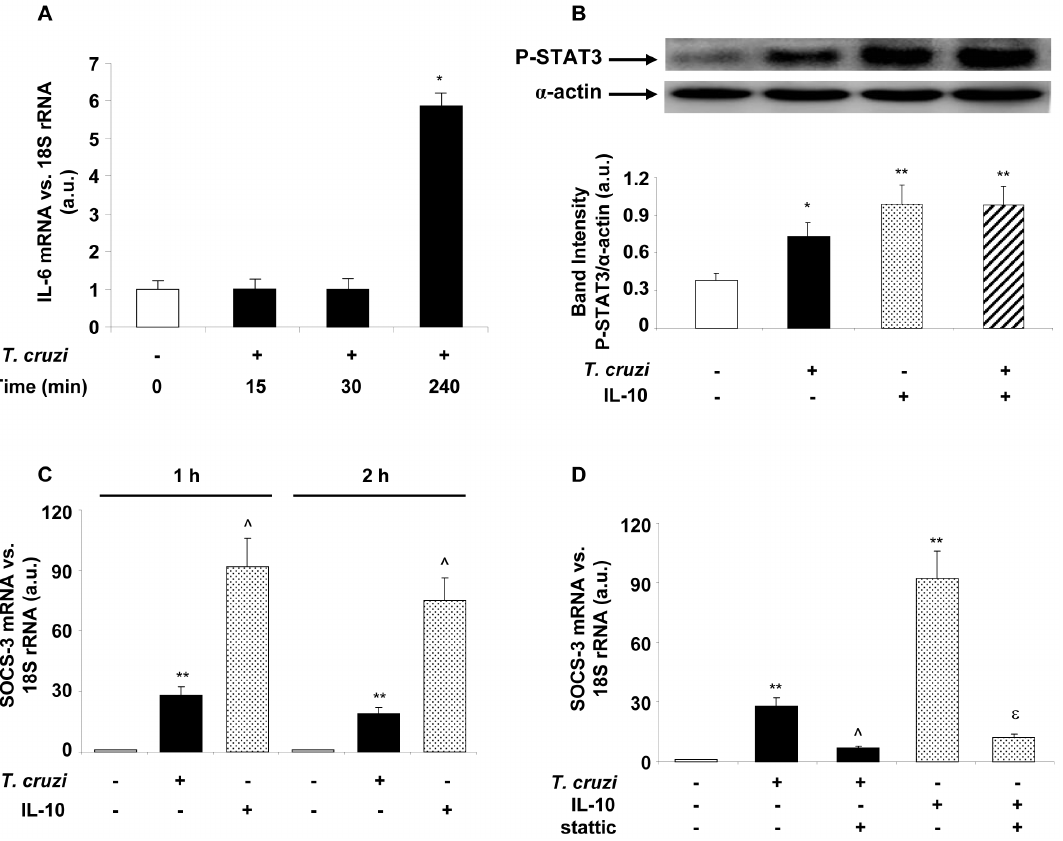
Figure 2. T.cruzi and IL-10 promote STAT3 activation and SOCS-3 expression. (A) Kinetics of IL-6 transcription after T. cruzi infection of cardiomyocytes. Cells were infected with T. cruzi trypomastigotes and at different time points mRNA for IL-6 was assessed using Q-RT-PCR. (B) Cells were infected or treated with IL-10 (20 ng/ml) or pre-treated with IL-10 and infected for 30 min and STAT3 activation was analysed by Wb. (C) Neonatal cardiomyocytes were infected or treated with IL-10 (20 ng/ml) for 1 or 2 h, and SOCS-3 mRNA levels were analysed by Q-RT-PCR. (D) Cells were pre-incubated with STAT3 inhibitor, stattic (10 m M), for 30 min before 1 h of T. cruzi infection or IL-10 treatment and SOCS-3 mRNA levels were analysed by Q-RT-PCR. For A, C and D, results were normalized against 18S and represent the mean 6 SD of three independent experiments. For B, results show the mean 6 SD (n=3) and protein levels were normalized against a -actin. **p , 0.01 vs. control cells; *p , 0.05 vs. control cells;ˆp , 0.01 vs. T. cruzi infected cells; e p , 0.01 vs. IL-10 treated